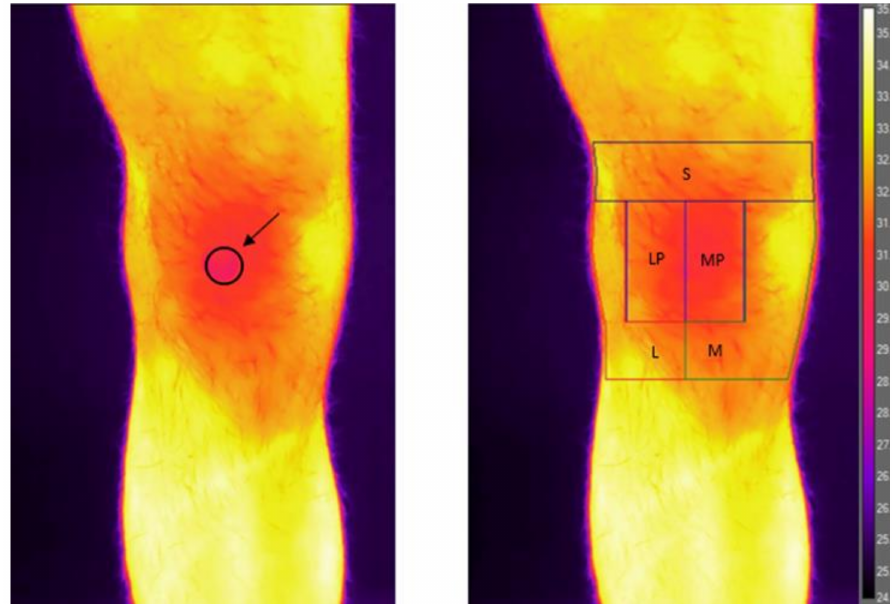
Figure 1. Infrared thermography analysis. On the left, the infrared image obtained with the patellar marker (identified with circle and arrow), while on the right, the image obtained with the con- sidered region of interest (ROI): L, lateral; LP, lateral patella; M, medial; MP, medial patella; and S,